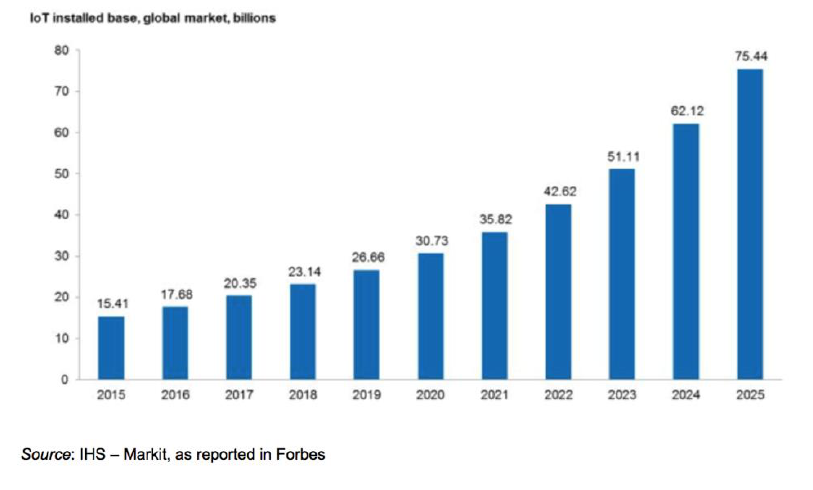
Figure 1: IoT Installed base, global market,